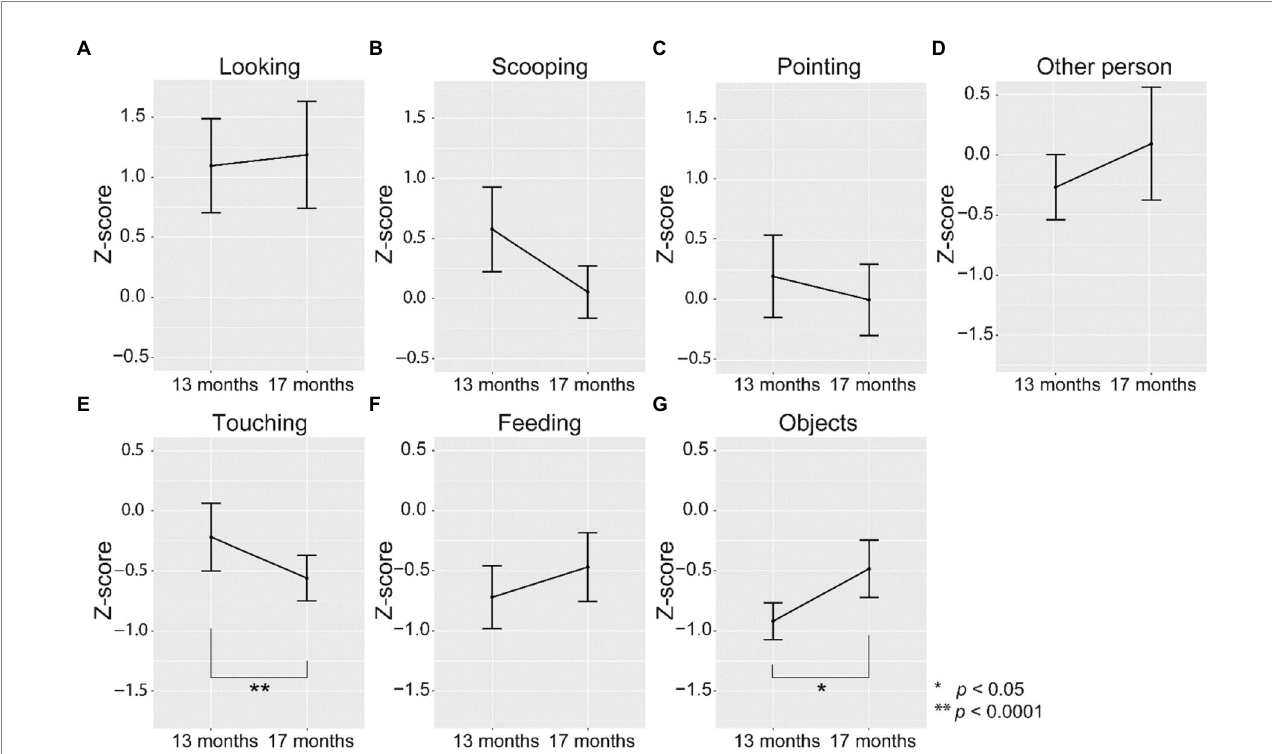
FIGURE 5 Comparison of z -scores between 13 and 17 months (A) when the caregiver did nothing and just looked at the toddler, (B) when the caregiver was scooping food, (C) when the caregiver was pointing, (D) when the caregiver acts for other toddlers or caregivers, (E) when the caregiver was touching the toddler with contact, (F) when the caregiver was feeding the toddler, and (G) when the caregiver was manipulating the object. The figure is based on the data from the three observations of lunchtime for six children at two time points (13 months and 17 months of age). Error bars represent the standard error of the